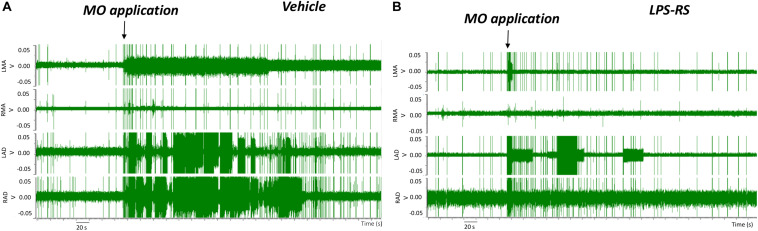
Examples of electromyographic (EMG) traces before and following mustard oil (MO) application to the first maxillary molar tooth pulp of rats treated 10 min earlier with i.t. application of either vehicle (A) or LPS-RS (B). The four traces show the EMG activities (Volts, “V”) of the left masseter (LMA), right masseter (RMA), right anterior digastric (RAD), and left anterior digastric (LAD) muscles.